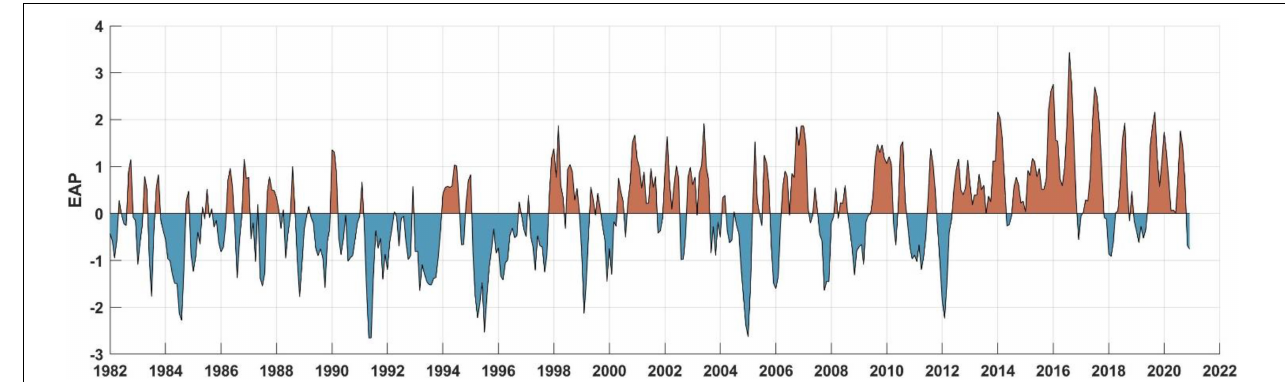
FIGURE 10 | Standardized 3-months running mean values of the Eastern Atlantic Pattern (EAP) index from 1982 to 2020. Note that the strongest positive phase of EAP coincided with the most intense MHW event throughout the summer of